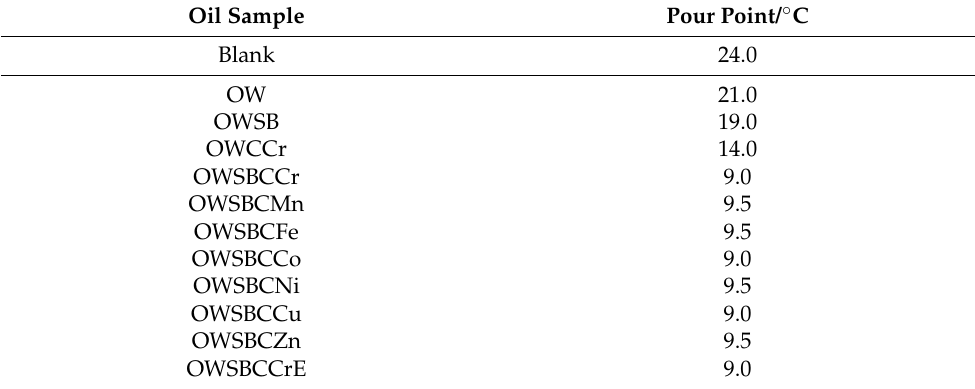
Table 2. The effect of the catalysts on the L8401 pour point depression.